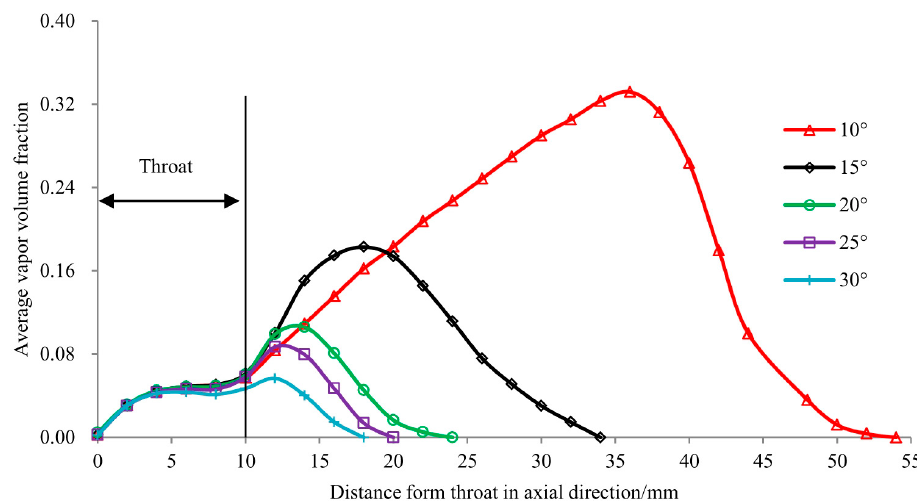
Figure 8. Average vapor volume fraction of cross-section from the throat in the axial direction with different diffusion angles.